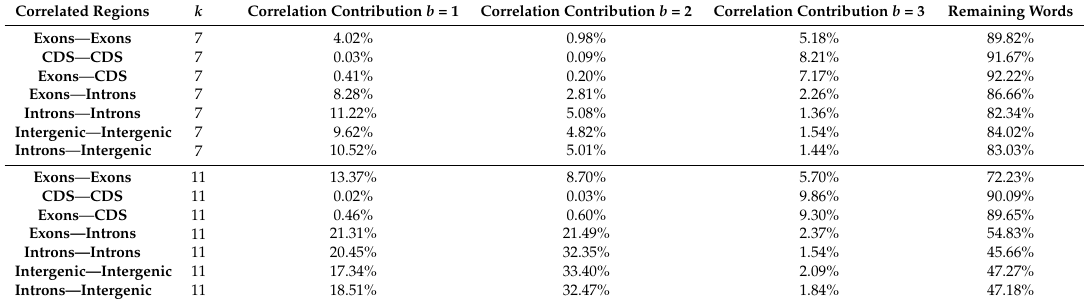
Table 5. Correlation contributions of tandem repeats with different repeat unit lengths b (in base pairs) for word lengths k = 7 and k = 11, between different genome regions analogous to the data shown in Figure